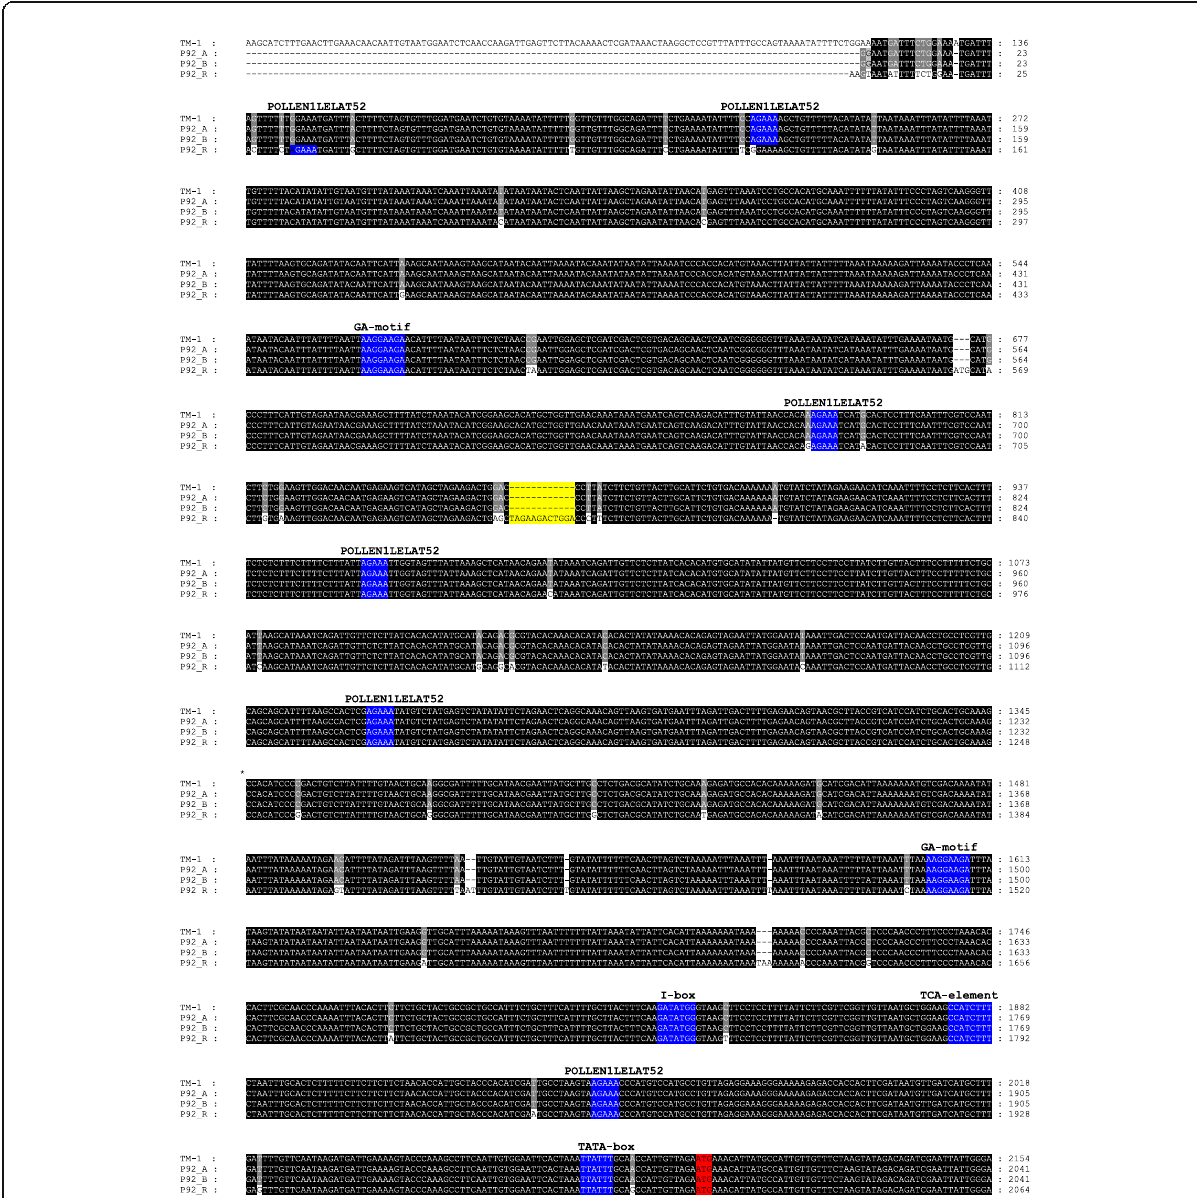
Fig. 3 Multiple alignments for promoter sequence of Gh_D05G3392 gene in CMS-D2 line A, maintainer line B, and restoration line R. The red color represent the translation start site. The yellow color represent the insertion in the restorer R line. The blue color represent specific cis -regulatory elements in the promoter